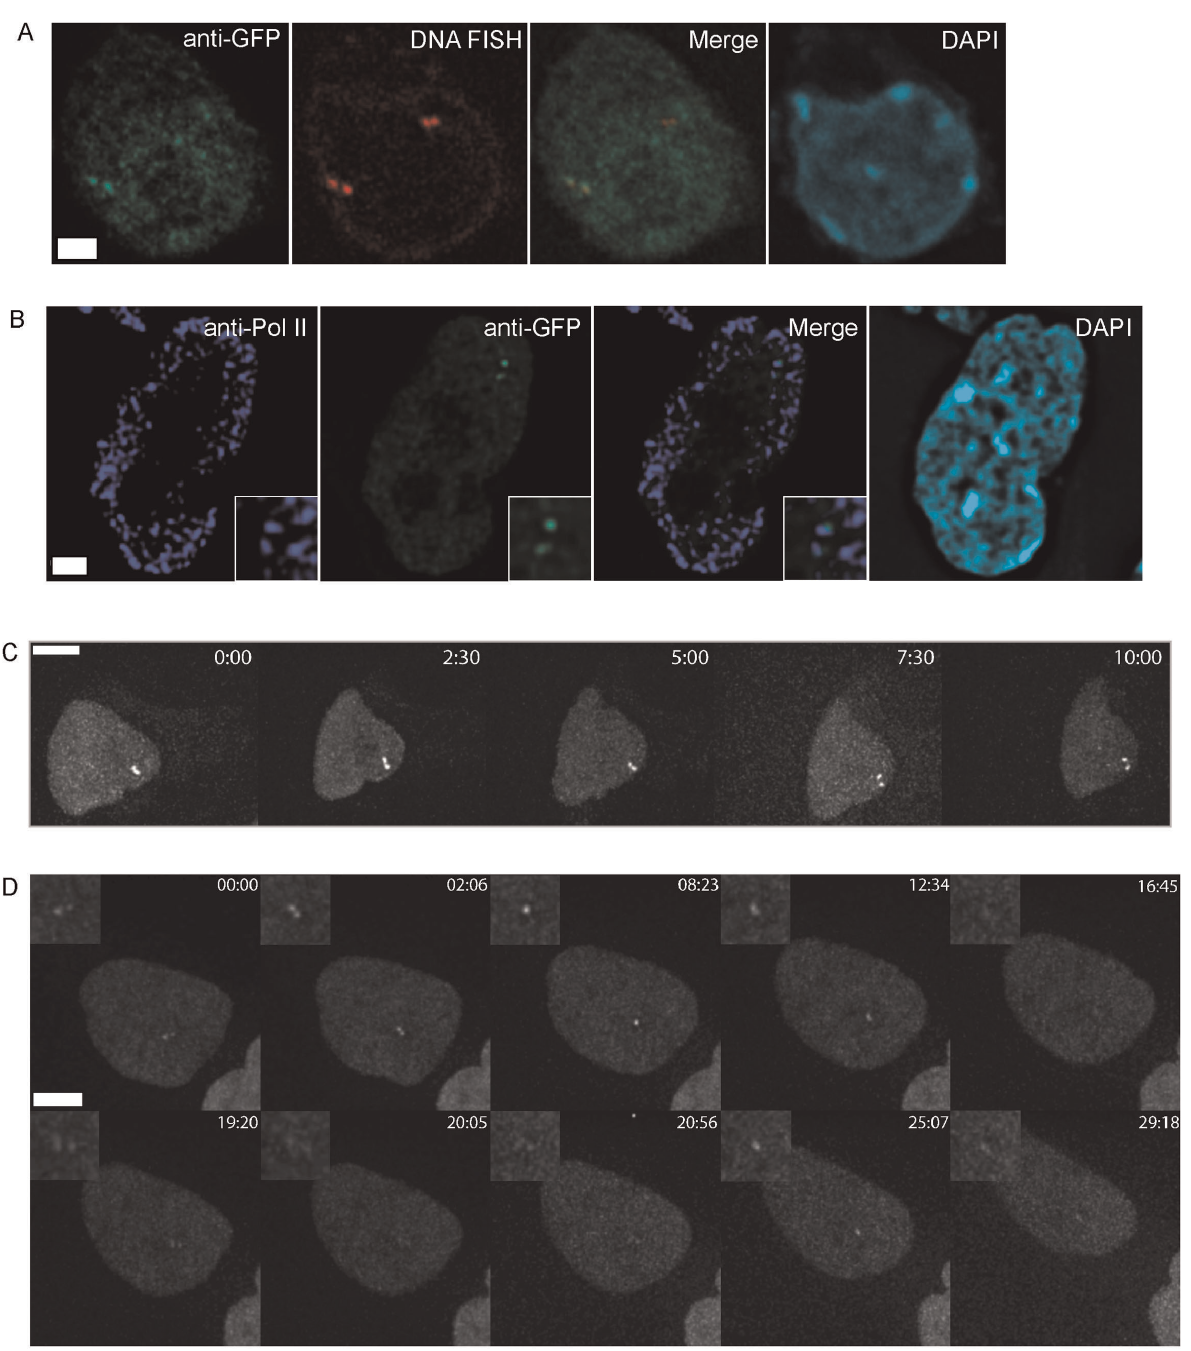
Figure 7. Focal doublets on sister chromatids associate with transcription factories. A. Transcription doublets can be seen in a cell that has undergone replication at the integration site. The pair of transcription foci (green) overlaps the replicated DNA FISH signals (red) on one pair of alleles. The nucleus is counterstained with DAPI (cyan). B. ImmunoFISH of Clone B6 focal doublets (green) show they associate with distinct RNA Pol II factories (violet). A single focal plane with focal doublets is shown. The nucleus is counterstained with DAPI (cyan). Scale bar=2.5 m M. C. Detection of transcriptional doublets in Clone 3A10 persisting through 10 minutes of image acquisition. Scale bar=2.5 m M. D. Dynamics of transcription doublets in Clone B6. Scale bar=2.5 m